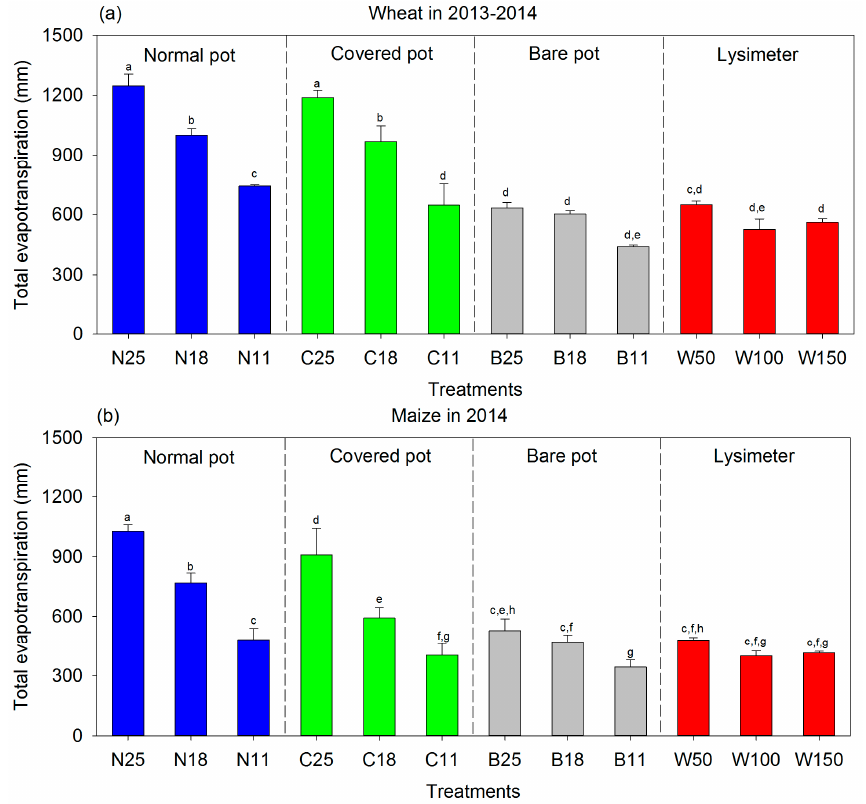
Figure 8. The uncorrected total evapotranspiration of ( a ) wheat and ( b ) maize of the pot and lysimeter experiments. The three soil moisture content treatments applied were 11 ± 2%, 18 ± 2%, and 25 ± 2% for normal pots with a crop (N11, N18, N25), for covered pots with crops (C11, C18, C25), and for bare soil without crops (B11, B18, B25), respectively. The three water-deficit treatments applied to the lysimeters were controlled to 50 ± 15 mm (W50), 100 ± 15 mm (W100), and 150 ± 15 mm (W150), relative to the field water capacity. Different letters (a, b, c, d, e, f, g, h) denote significant differences between treatments (p < 0.05). Water 2019 , 11 FOR PEER REVIEW